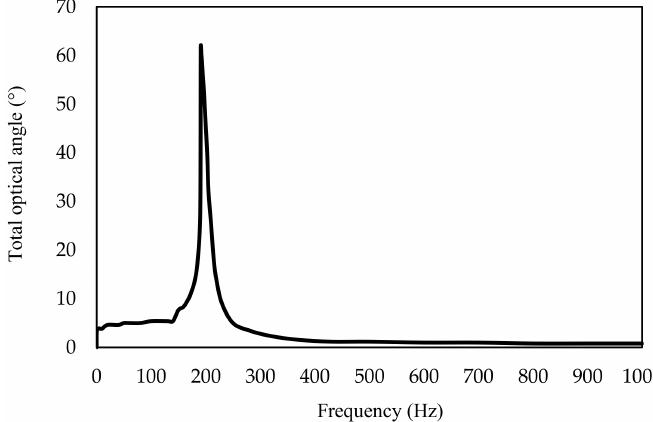
Figure 7. Tested results of dynamic rotation of the FPCB